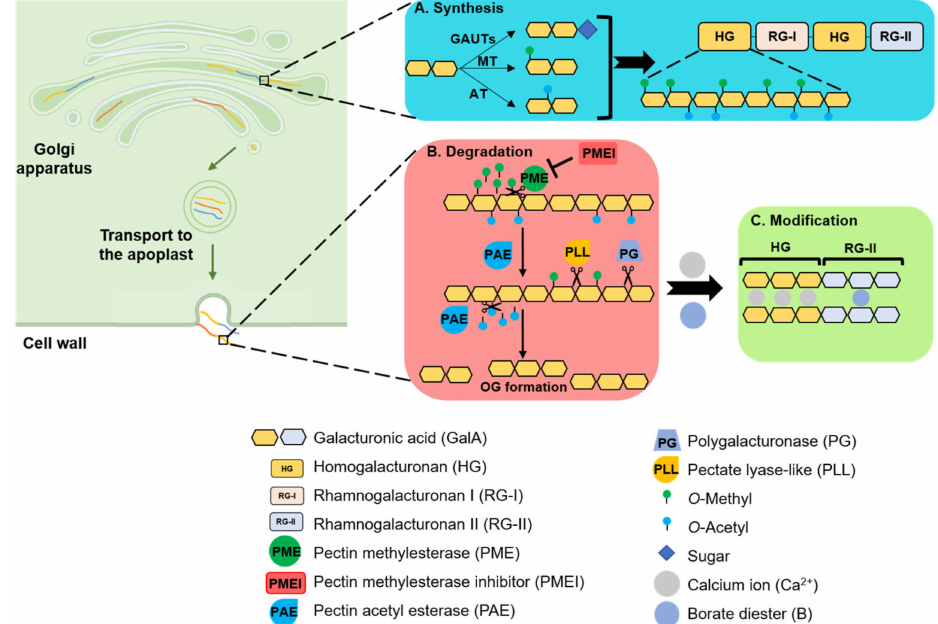
Figure 1. An overview of the synthesis, degradation, and modification of pectin in the plant cell wall. ( A ) Pectins— structurally complex polysaccharides including homogalacturonan (HG), rhamnogalacturonan I (RG-I), and rhamnogalac- turonan II (RG-II)—are synthesized in the Golgi apparatus. HG is synthesized by the glucuronosyltransferase (GAUT) family of enzymes and modified by methyltransferase (MT) and acetyltransferase (AT). ( B ) The highly methylesterified pectin is delivered to the cell wall surface via vesicle-mediated transport and incorporated into the cell wall. HG is selectively demethylated via the wall-bound pectin methylesterases (PMEs) and deacetylated via pectin acetylesterases (PAEs). PME activity is controlled by the proteinaceous pectin methylesterase inhibitor (PMEI). Pectinolytic enzymes such as polygalacturonase (PG) and pectate lyase-like (PLL) are important for HG depolymerization, which results in the formation of oligogalacturonides (OGs). ( C ) Antiparallel polyuronate chains of HG form egg-box dimers with Ca 2+ , and HG backbones of the RG-II polysaccharides are covalently linked via borate diester